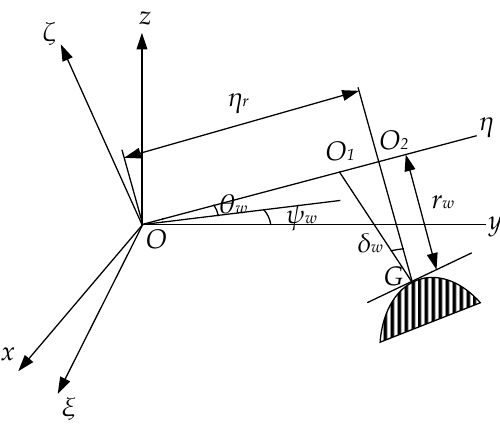
Figure 3. The contact geometry of the wheel / Figure 2. The contact geometry of the wheel/rail.